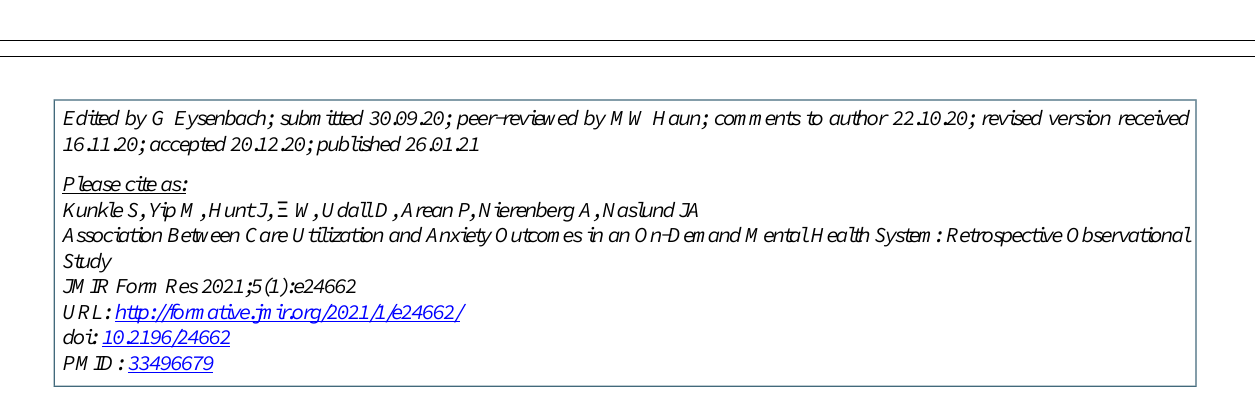
GAD: Generalized Anxiety Disorder PHQ: Patient Health